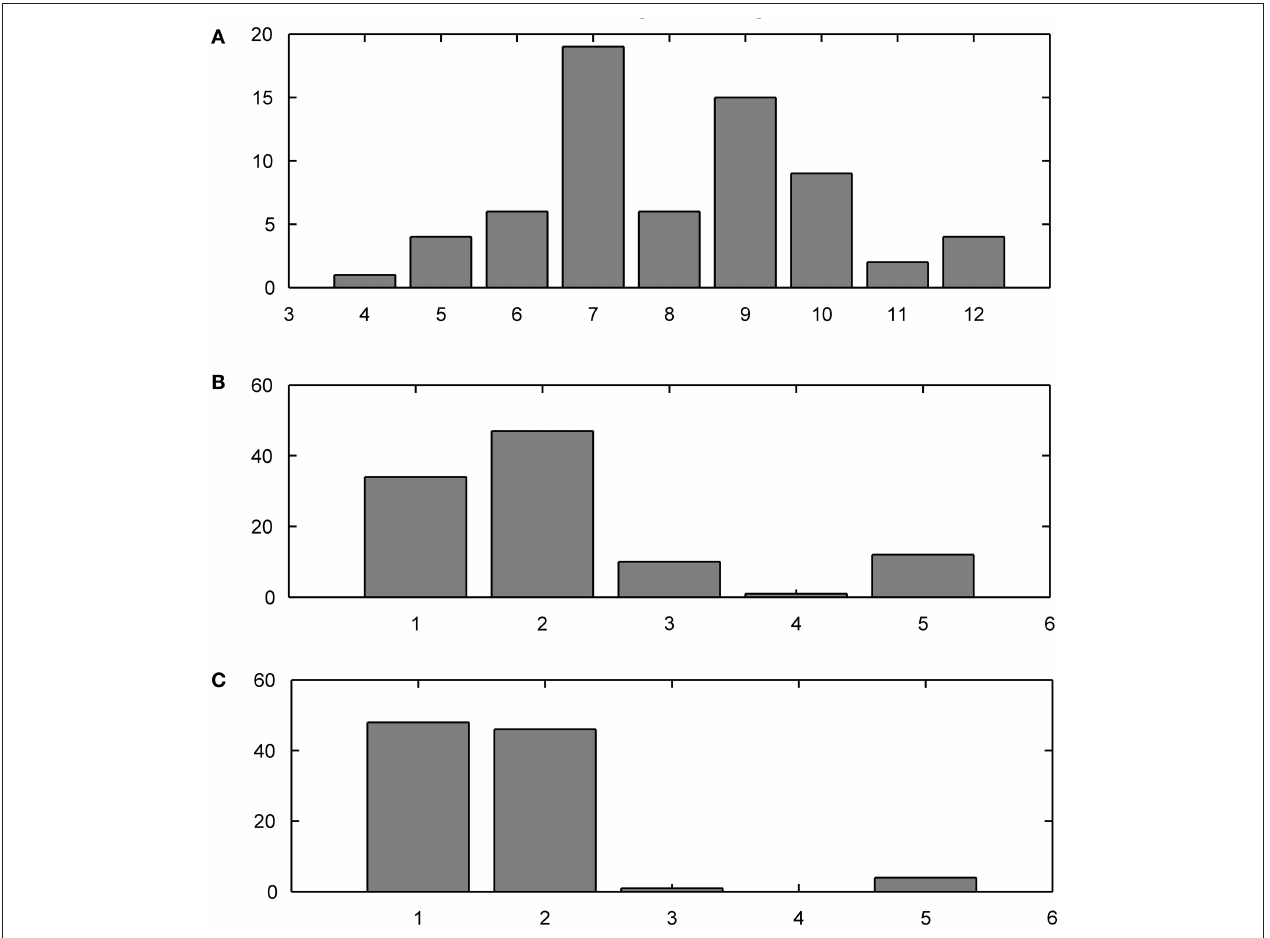
Figure 7 | Training corpus word frequency histogram (A) and saccade frequency histogram test results; (B) THSOM model; (C) T 2 HSOM